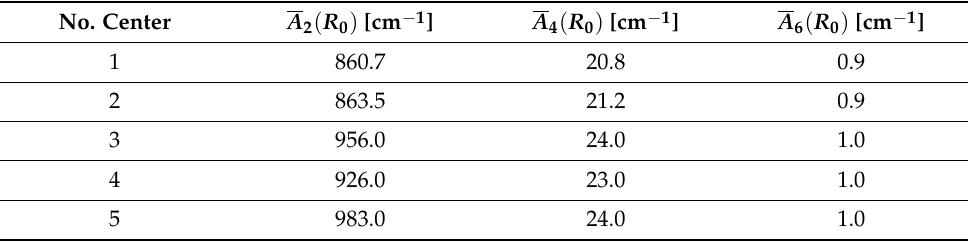
Table 4. The best fitting results of the intrinsic parameters A 2 ( R 0 ) , A 4 ( R 0 ) , A 6 ( R 0 ) and the angular distortion ∆ θ [ 0 ] for paramagnetic centers in the BaWO 4 : Ce and BaWO 4 : Ce, Na single crystals with axial